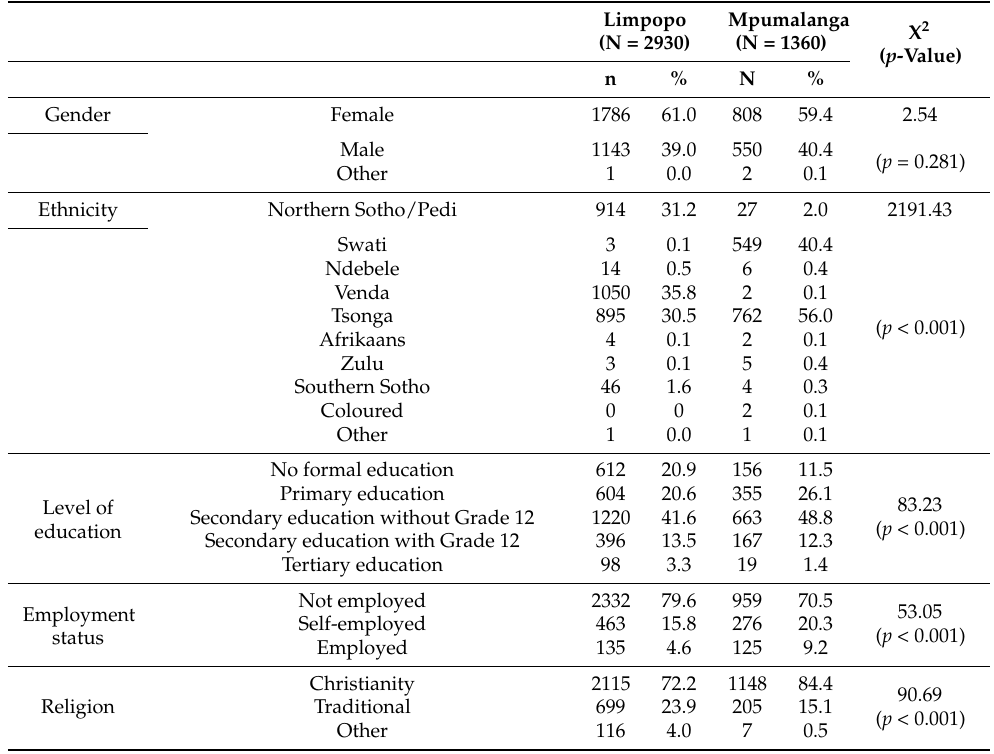
Table 1. Demographic characteristics of community members.